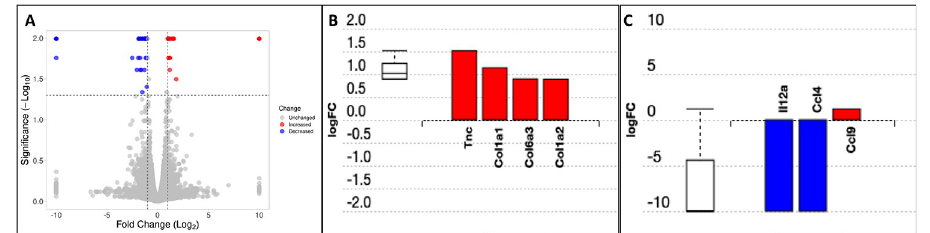
Fig 9. Gene expression differences in IL-22:Fc treated animals. Animals treated with IL-22:Fc after high-dose LPS injury have increased transcription of extracellular matrix components and decreased transcription of Interleukin-12a (IL12a) and Macrophage Inflammatory Protein-1 β (CCL4). RNAseq data demonstrating A) volcano plot, B) increased expression of tenacin C, Tenascin C (Tnc), collagen, type I, alpha 1 (COL1a1), collagen, type VI, alpha 3 (Col6a3), and collagen, type I, alpha 2 (Col1a2), and C) decreased expression of IL-12a and CXCL4 genes for IL-22:Fc treated.